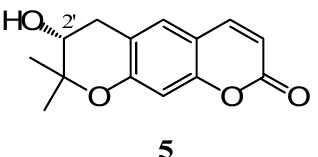
Figure 2 . Structure of aegelinol.